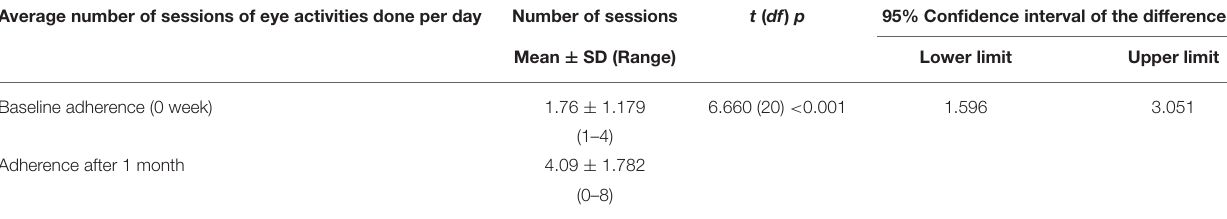
TABLE 4 | Comparison of mean score of baseline adherence with adherence after 1 month of intervention. Average number of sessions of eye activities done per